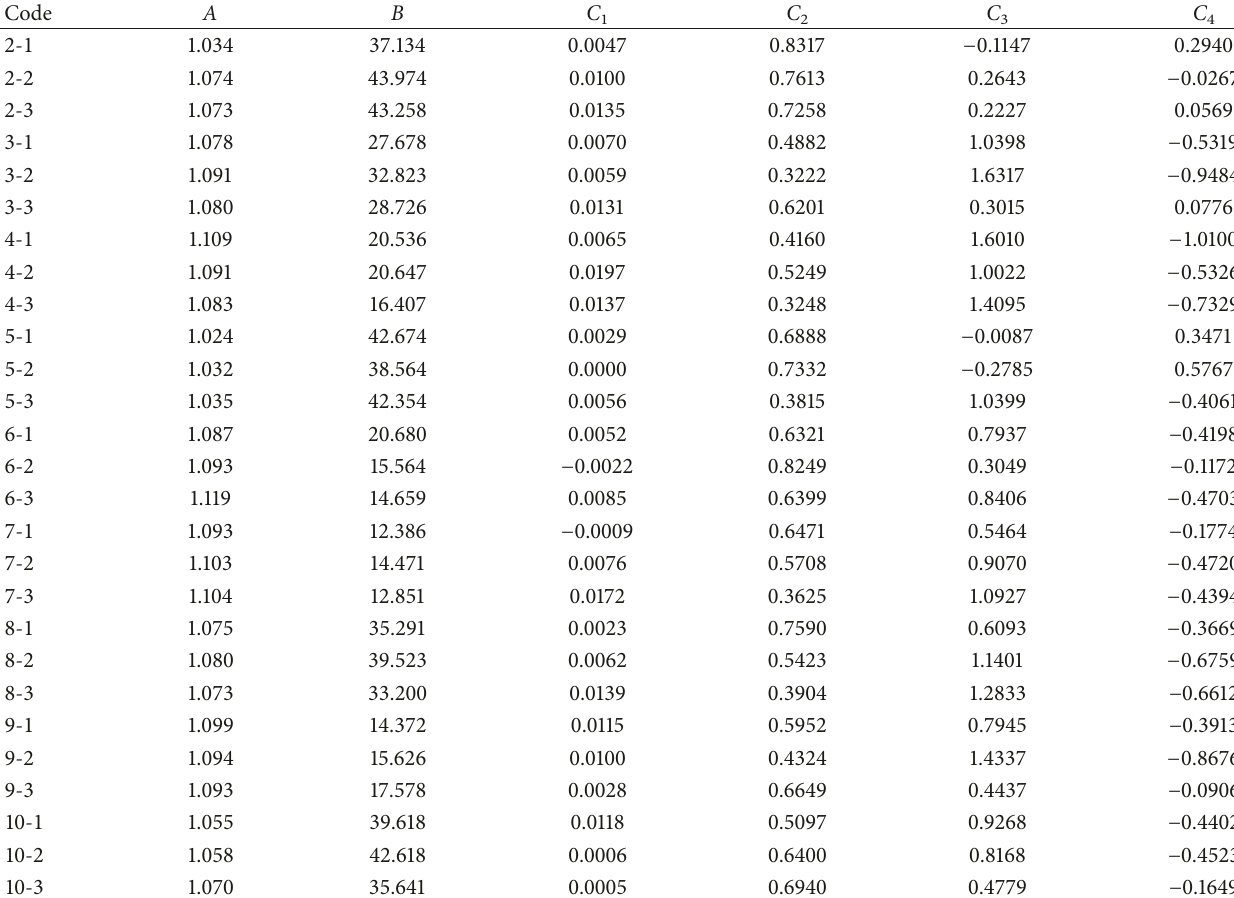
Table 5: Fitting